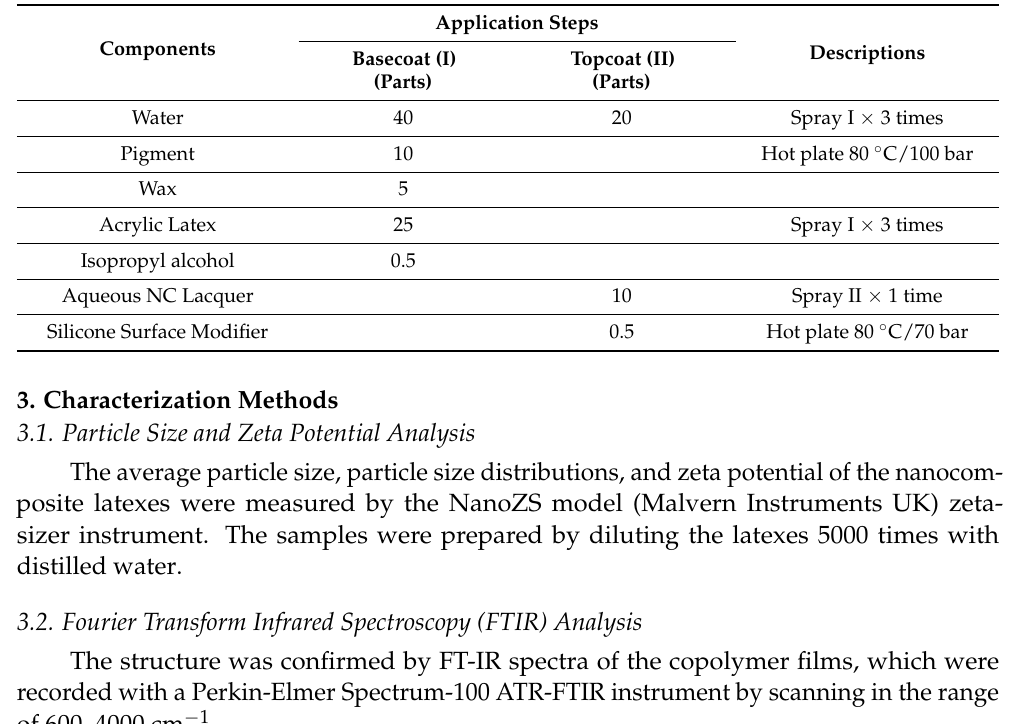
Table 2. The finish formulation applied on the